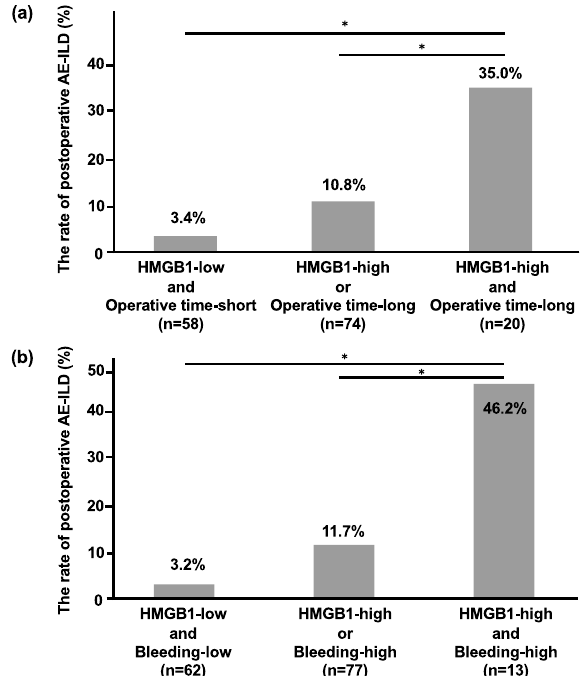
Figure 3. The risk stratification based on HMGB1 and factors related to surgical invasiveness. The cut-off levels of operative time and bleeding volume were 200 min and 155 mL, respectively. When HMGB1 and operative time/bleeding volume were combined, the incidence of postoperative acute exacerbation of interstitial lung disease (AE-ILD) in patients with both HMGB1-high and operative time-long/bleeding volume-high was significantly higher than that in the other two groups ( a , b ). * P < 0.05, using Pearson’s chi-squared